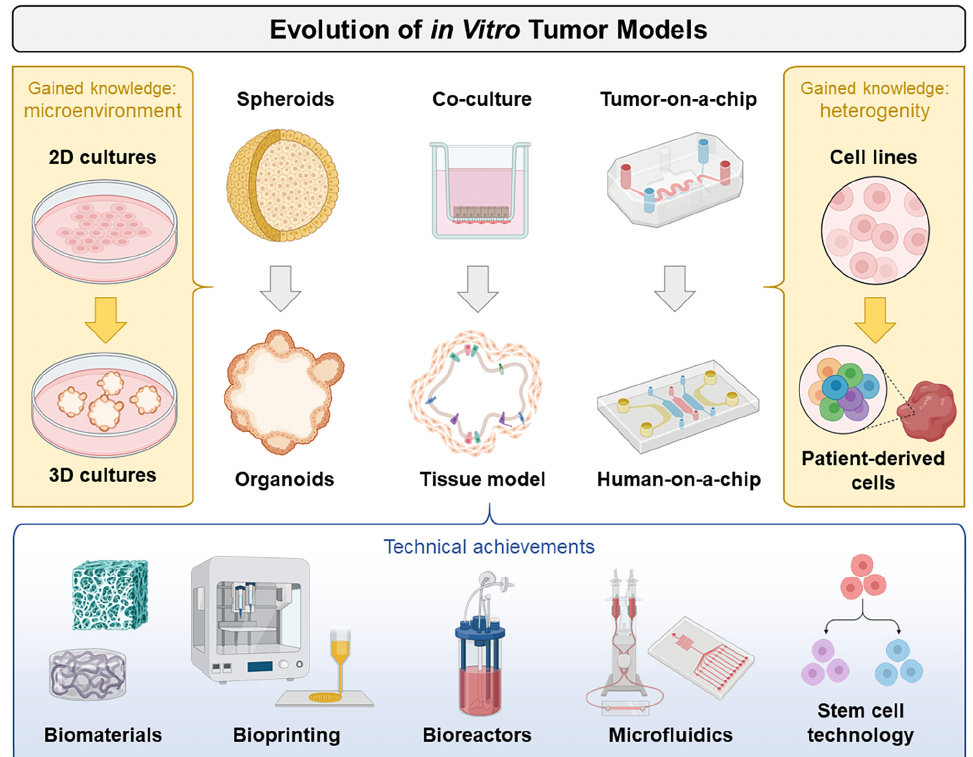
Figure 1. Illustrated overview of the evolution of in vitro tumor models. Increasing knowledge about the cell biology of tumors (yellow boxes) as well as technical progress with new methodological possibilities (blue box) are the driving forces for the further development of tumor models. The figure was created using elements from BioRender.com (accessed on 9 March 2023).